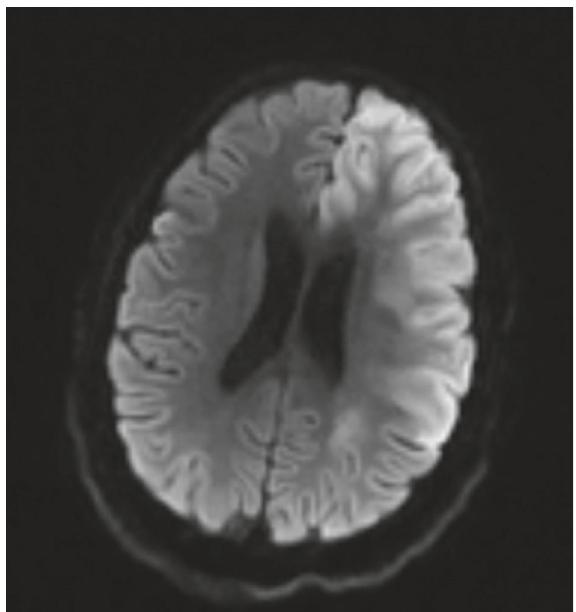
Figure 1: MRI brain without contrast performed during the pa- tient’s acute presentation to the emergency department showing large territory left hemispheric